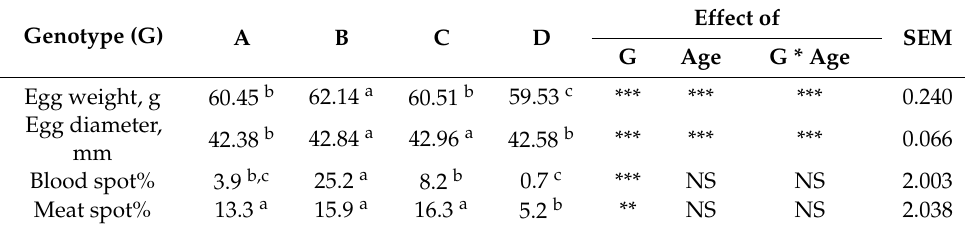
Table 4. Effect of hen genotype A, B, C, and D, age, and their interaction on LS-means of egg albumen parameters between the 21st and 54th week of age, n = 180 for genotype A and 270 for genotypes B, C and D.